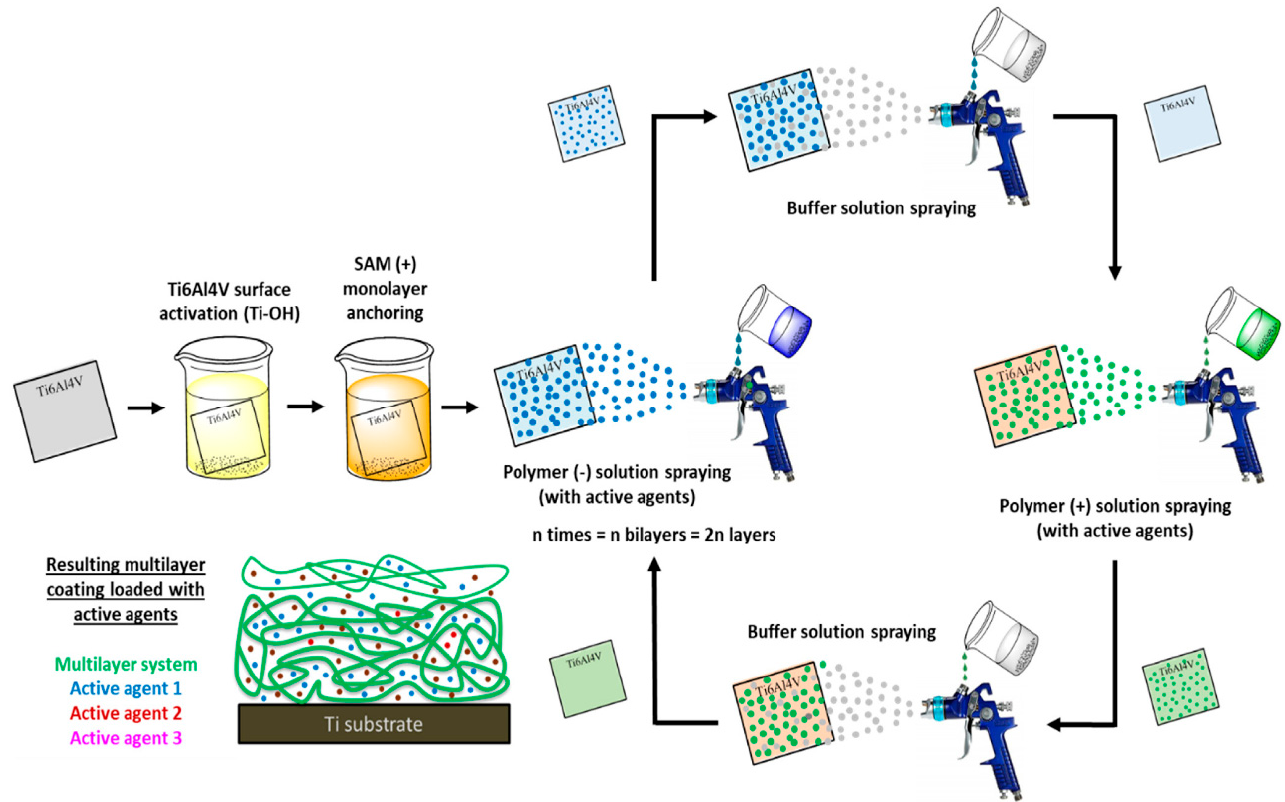
Figure 19. A generalized illustration of the LbL assembly technique using positively and negatively charged polymers to cover the Ti6 − Al − 4V substrate using preloaded active agents. Adapted with permission from [43] (MDPI) (2021). Distributed under Creative Commons Attribution-based license (CCBY 4.0.).